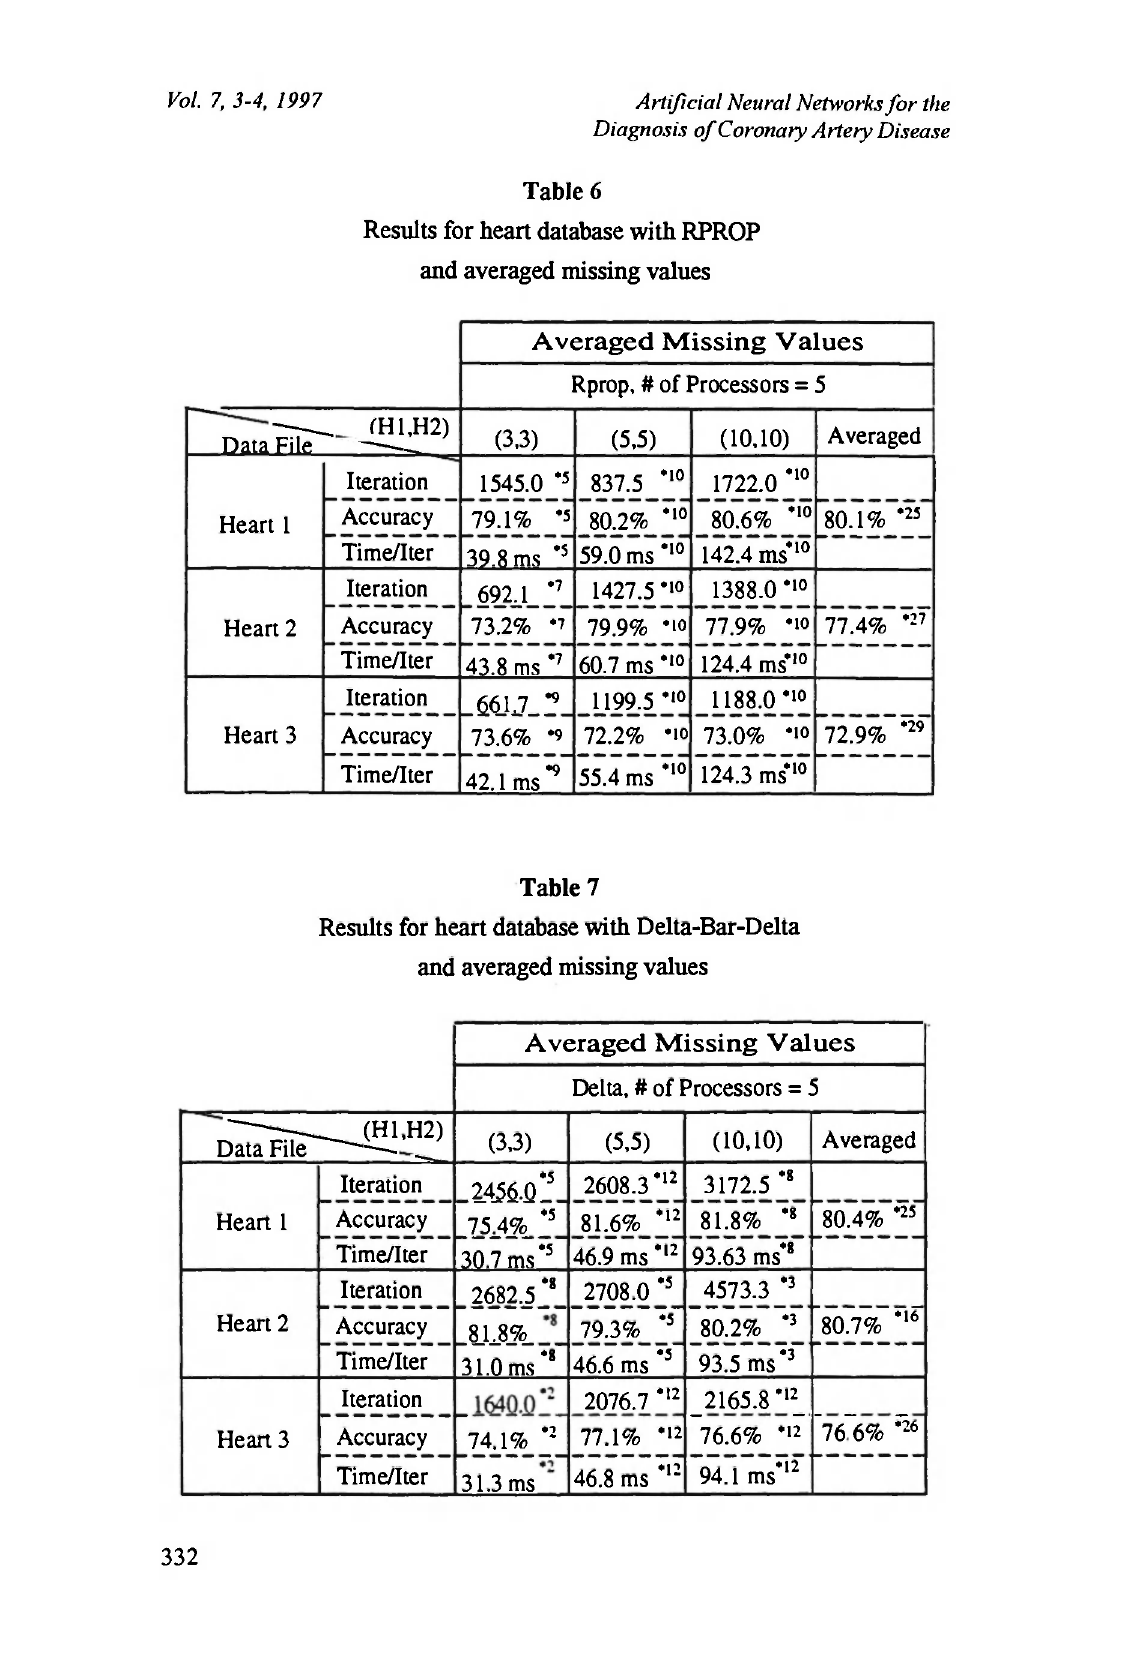
Results for heart database with RPROP and averaged missing values